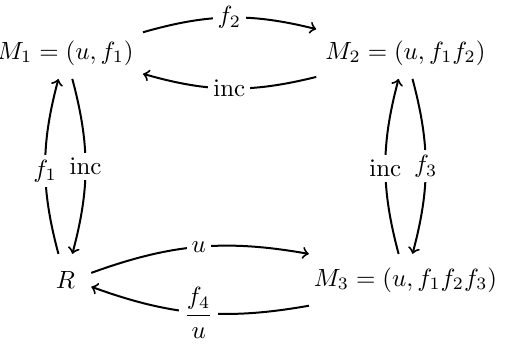
Figure 6. NCCR for P . Here f 1 = t; f 2 = z; f 3 = z (cid:0) t; f 4 = z (cid:0) (cid:21)t T 4 ; 4 ; 2 ; 2 ( (cid:21) )